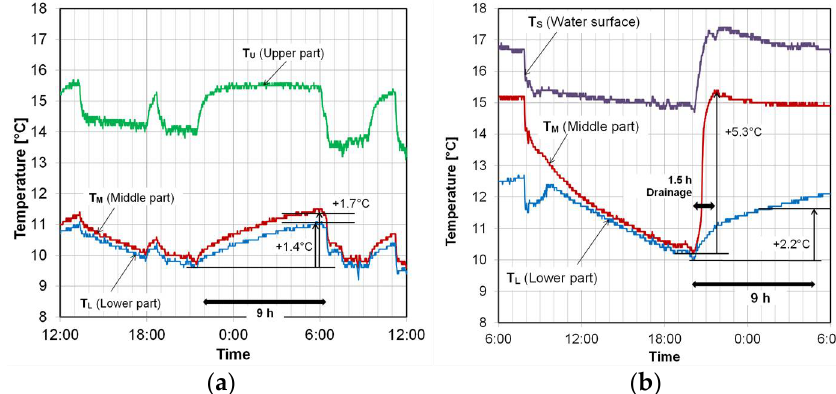
Figure 9. Comparison of temperature recovery with and without drainage: ( a ) no drainage pump operation and ( b ) drainage pump operation after using the heat pump.